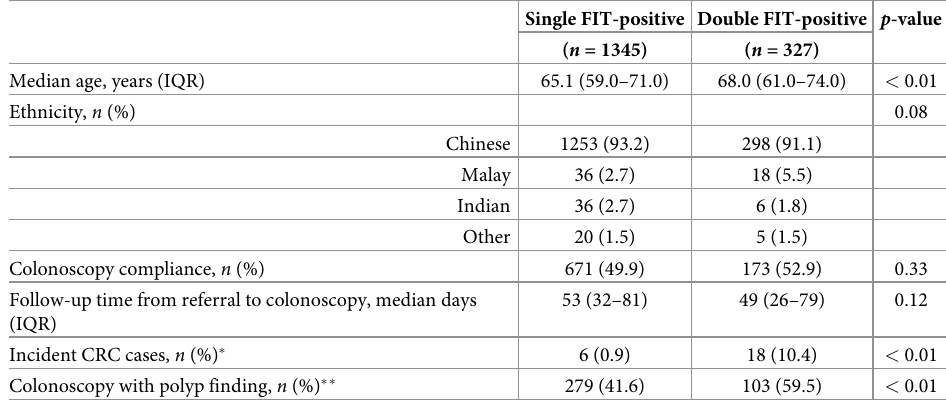
Table 1. Distribution of age, ethnicity and follow-up colonoscopy compliance between single FIT-positive and double FIT-positive